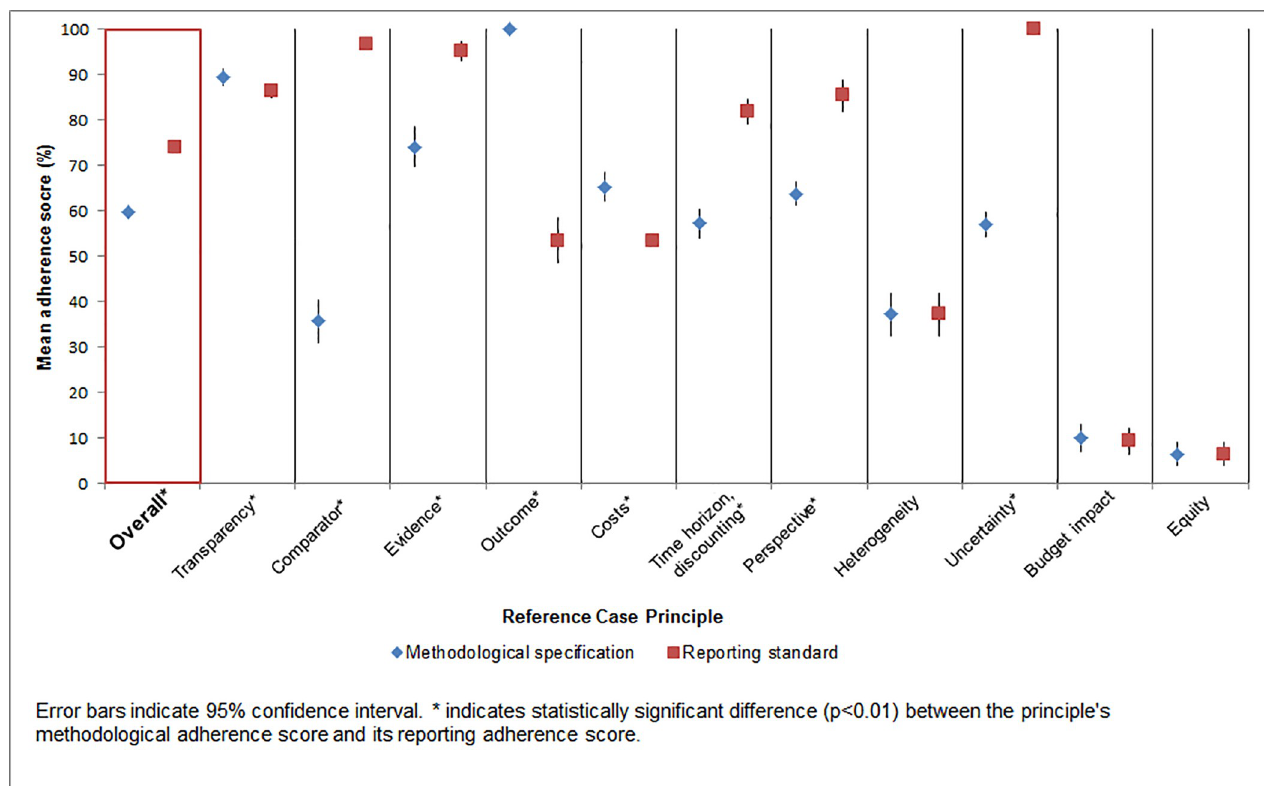
Fig 2. Methodological vs. reporting adherence scores: Overall and by each